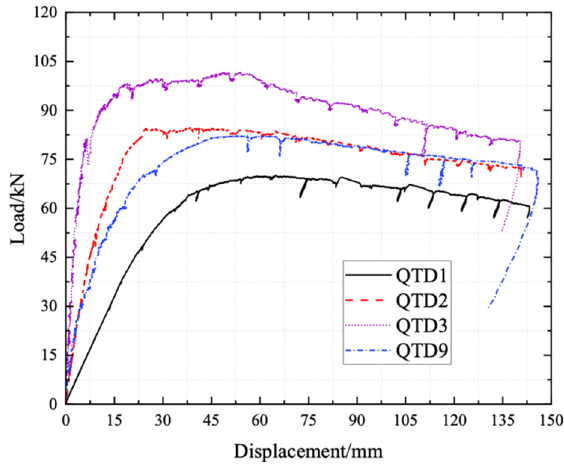
Figure 5. Load-displacement curves under the horizontal monotonic loading. Buildings 2023 , 13 , x FOR PEER REVIEW